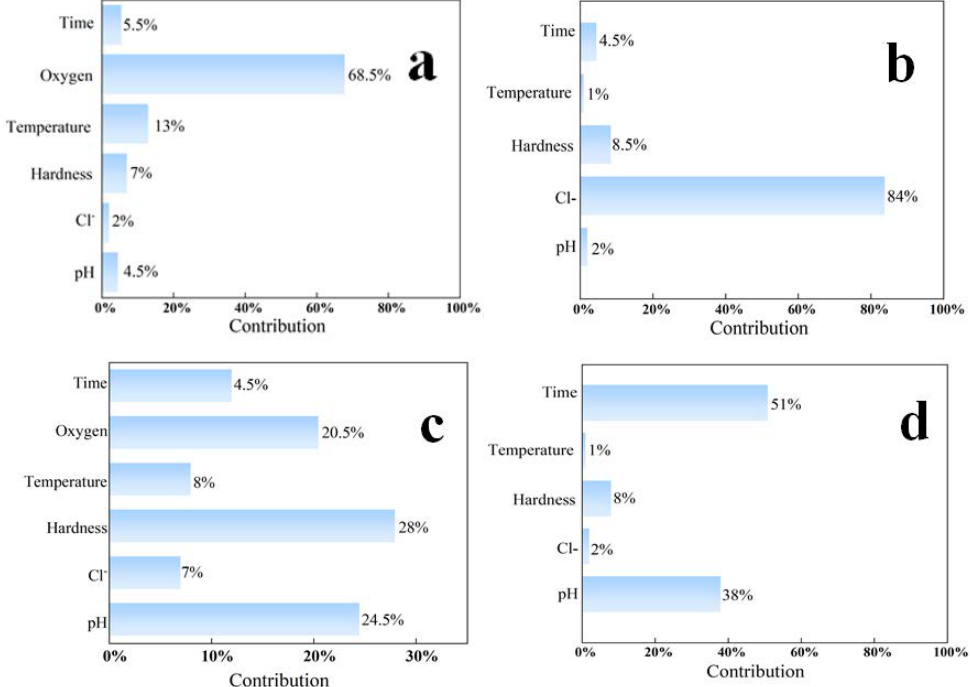
Figure 14. Analysis of the contribution of environmental factors to i corr . ( a , c ) show the contribution of non-surface-treated ductile iron in all environments and in fully oxygenated conditions, respectively; ( b , d ) show the contribution of the surface-treated ductile iron in all environments and in fully oxygenated conditions,